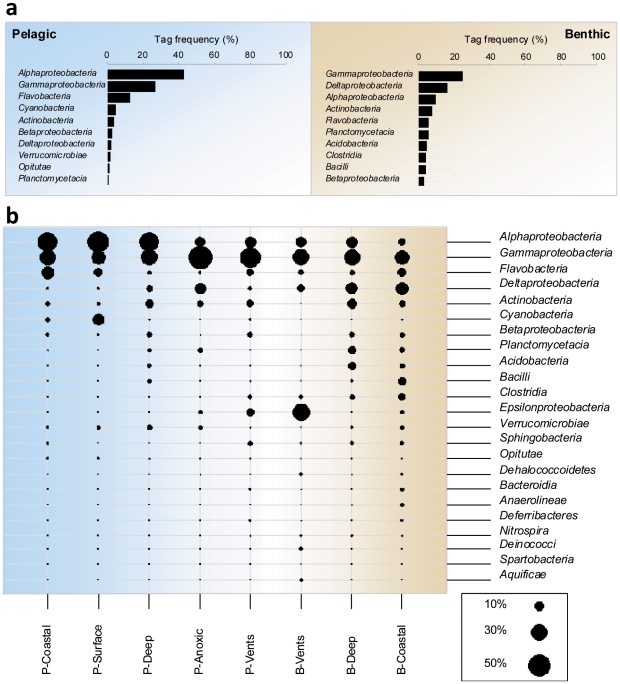
Bacterial community composition according to realms and ecosystem types.(a) Average sequence frequency for the ten most abundant bacterial classes in the pelagic and benthic realms. Error bars represent standard deviation values (number of samples indicated in Table 1). Vents and anoxic ecosystems were not taken into account for the average bacterial community composition in pelagic and benthic realms. (b) Average proportions of the main bacterial taxa per realm and ecosystem type. P =  Pelagic, B =  Benthic. Notice that taxonomic levels displayed here are not necessarily of the same level, but reflect the most common levels whose ecology and diversity are usually investigated in marine microbiology.